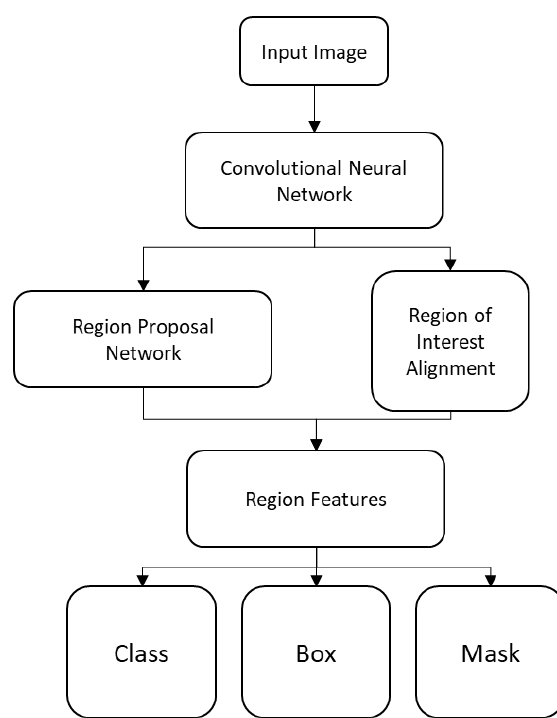
Figure 6. Architecture of Mask R-CNN (own illustration based on [15]).